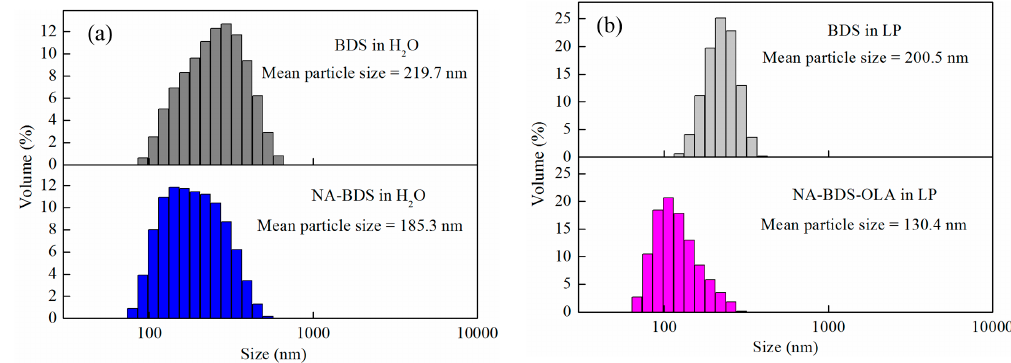
Figure 5. Particle-size distributions of ( a ) BDS and NA-BDS in H 2 O, and ( b ) BDS and NA-BDS-OLA in liquid paraffin (LP).